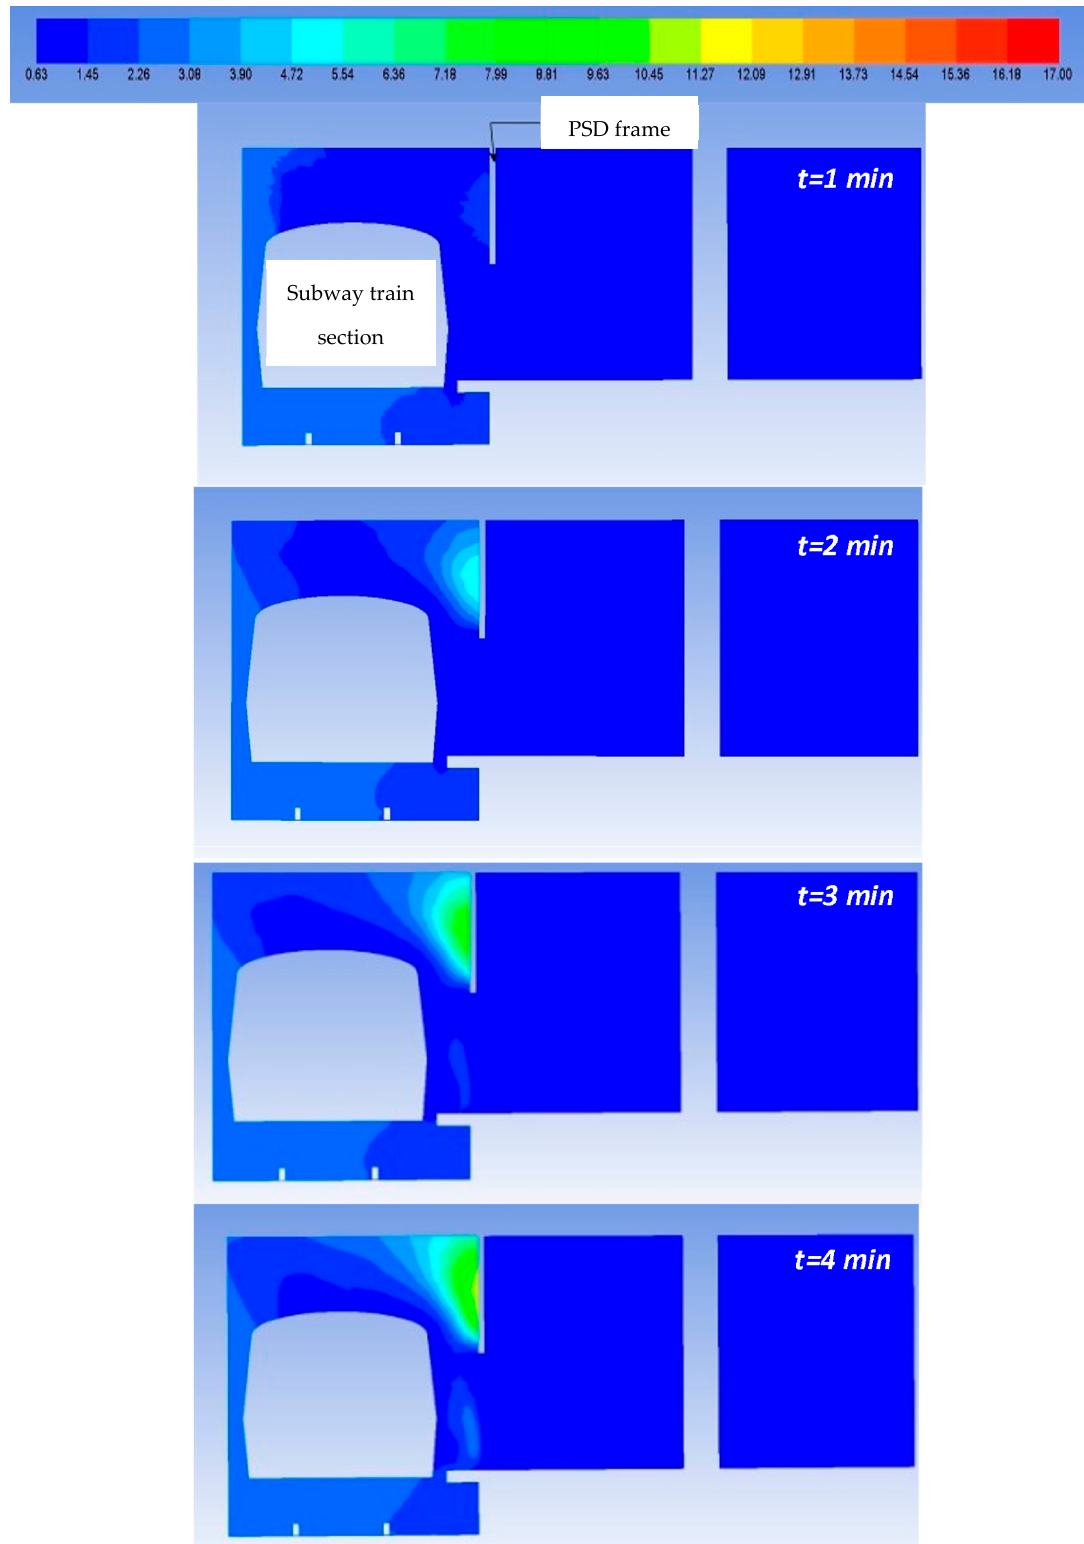
Figure 20. CO contours (ppm)—cross section through the door of the PSD system near the fire outbreak (minutes 1–4).